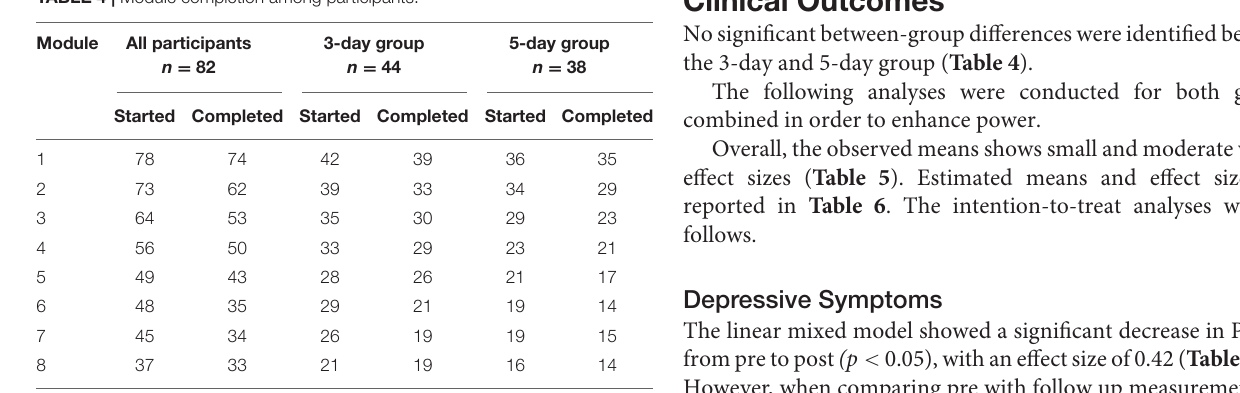
TABLE 4 | Module completion among